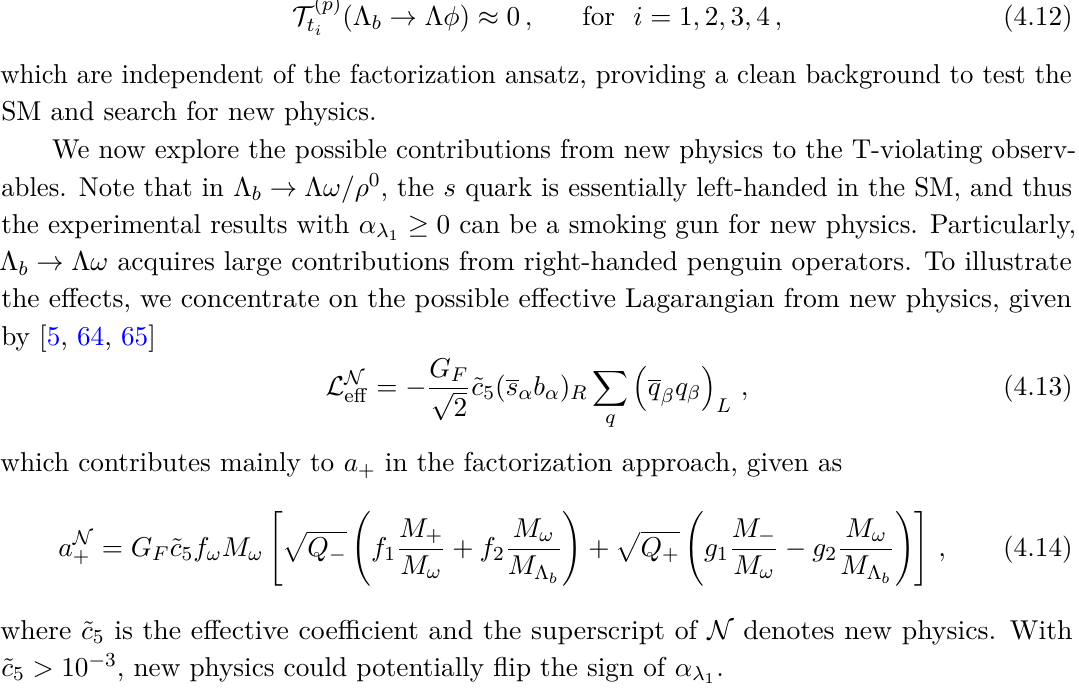
Λ φ is taken from ref. b →